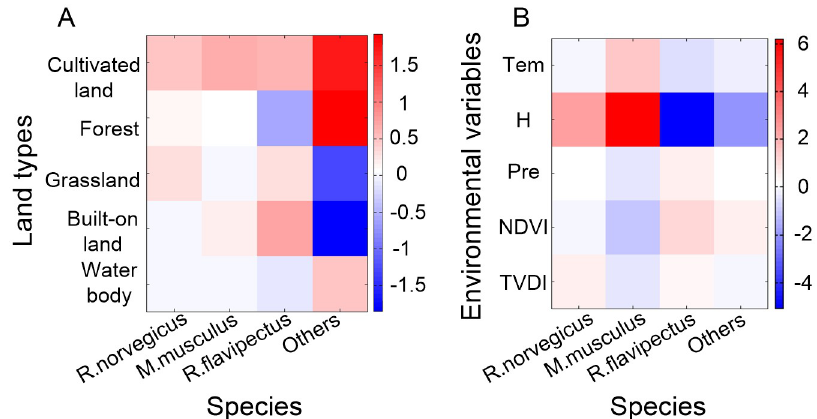
Fig 6. (A) Potential contact rates, as determined by potential contact matrix β , between humans and rodents among the different land-use types in Chenzhou; (B) Environment-to-rodent influence rates on different rodent species in Chenzhou for the different environmental variables, as determined by the environmental coefficient matrix α . Low values are shown in dark blue and high values in red. Positive values represent positive associations, and vice versa. Tem: temperature, H: relative humidity, Pre: precipitation, NDVI: the normalized difference vegetation index, TVDI: the temperature vegetation dryness index.